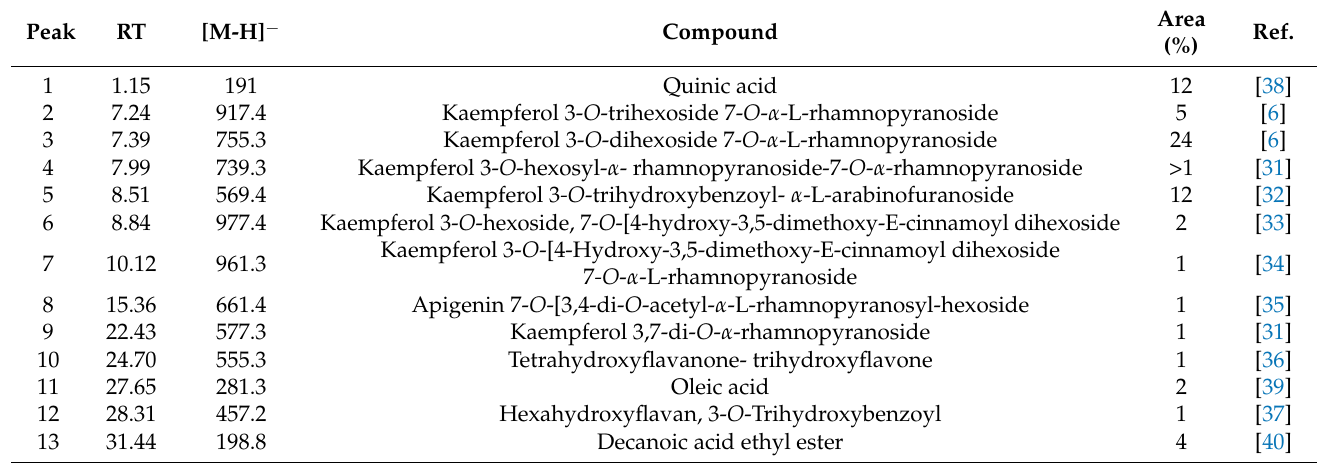
Table 1. LC-ESI-MS profiling of the methanol extract of the aerial parts of L. libyca .